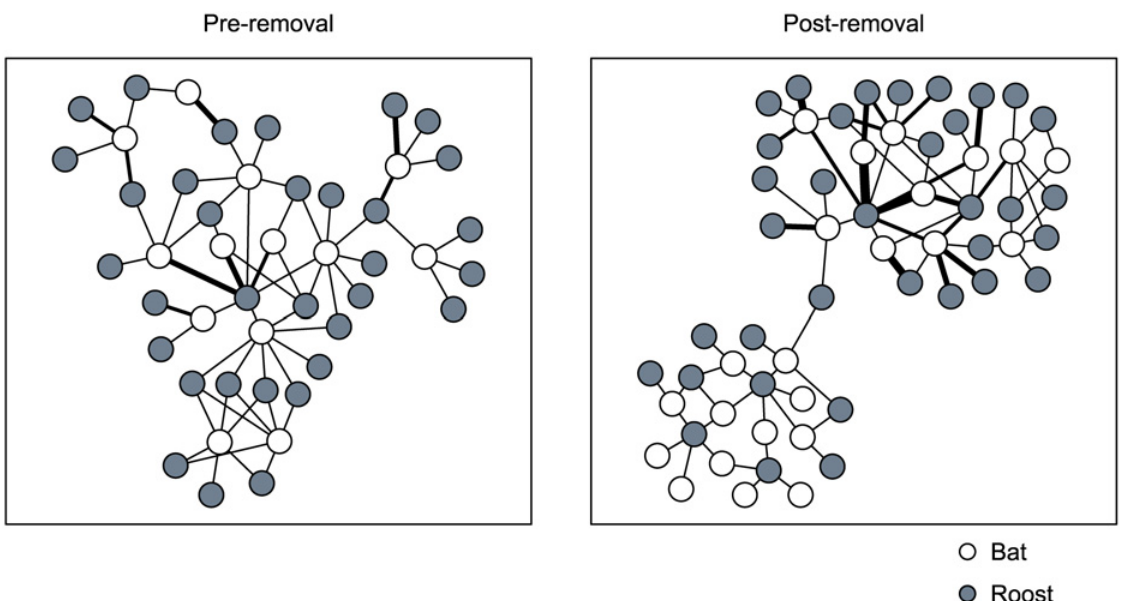
Figure 2. Northern long-eared bat maternity colony roost network map. Pre- and post- roost removal treatment (2011 and 2012) 2-mode roost network map of a northern long-eared bat ( Myotis septentrionalis ) maternity colony subjected to removal of 5 secondary roosts on the Fort Knox military reservation, Kentucky, USA. Edge width is scaled by the number of connections between a bat and an individual